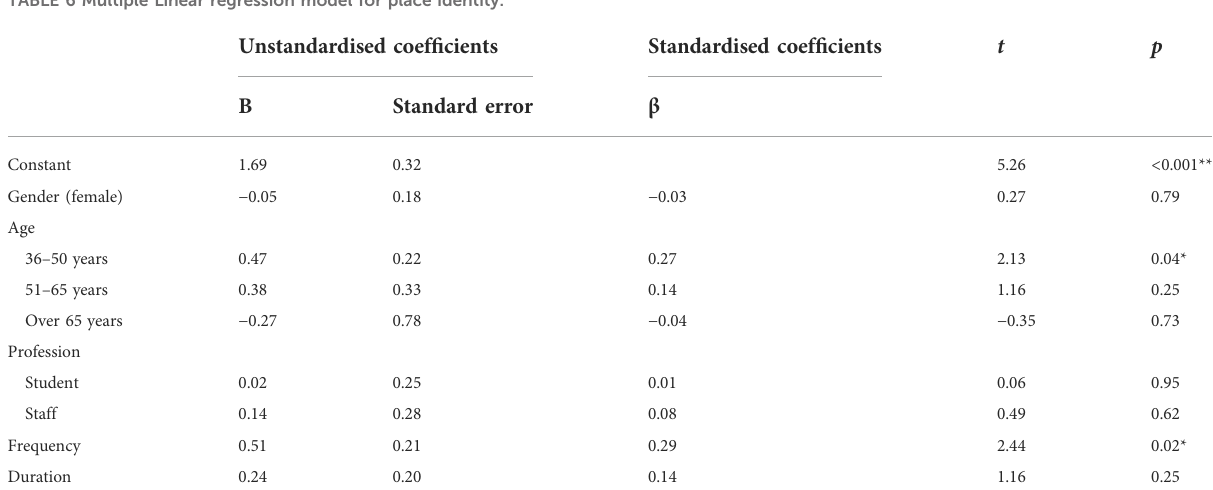
TABLE 6 Multiple Linear regression model for place